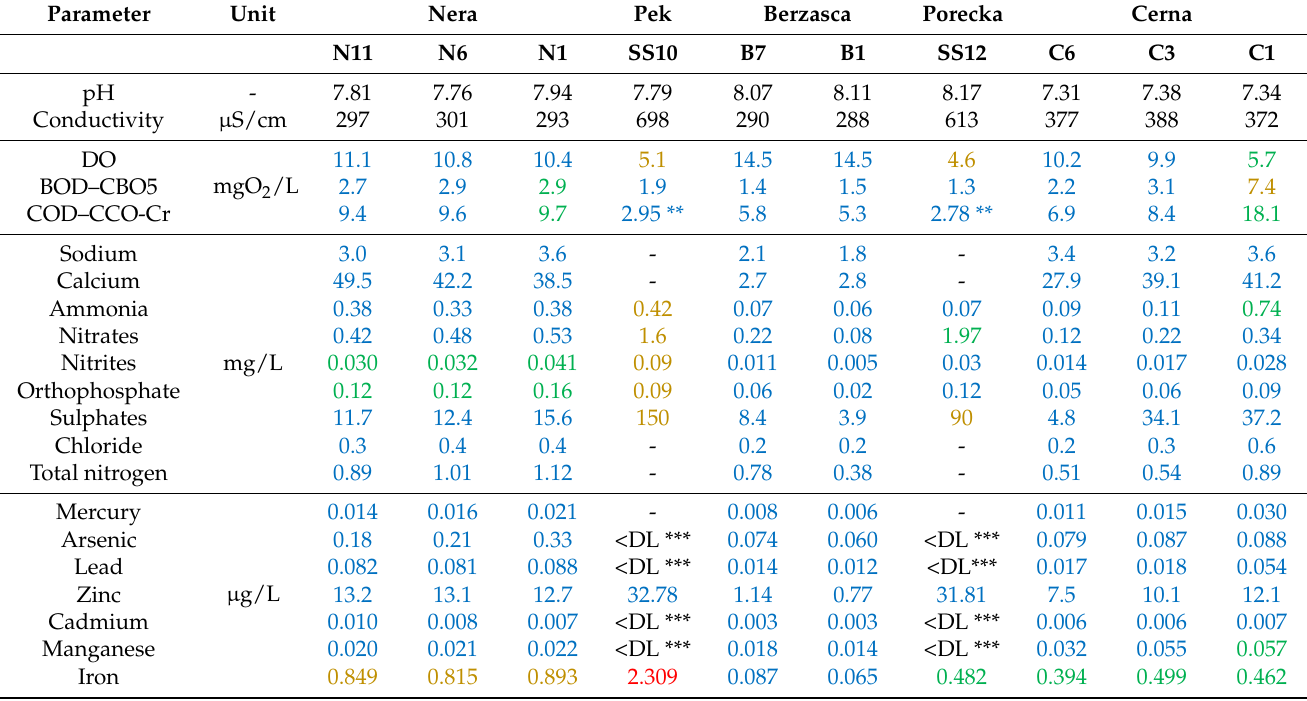
Table 4. Results obtained for parameter analysis in samples of Danube’s tributaries: Nera,